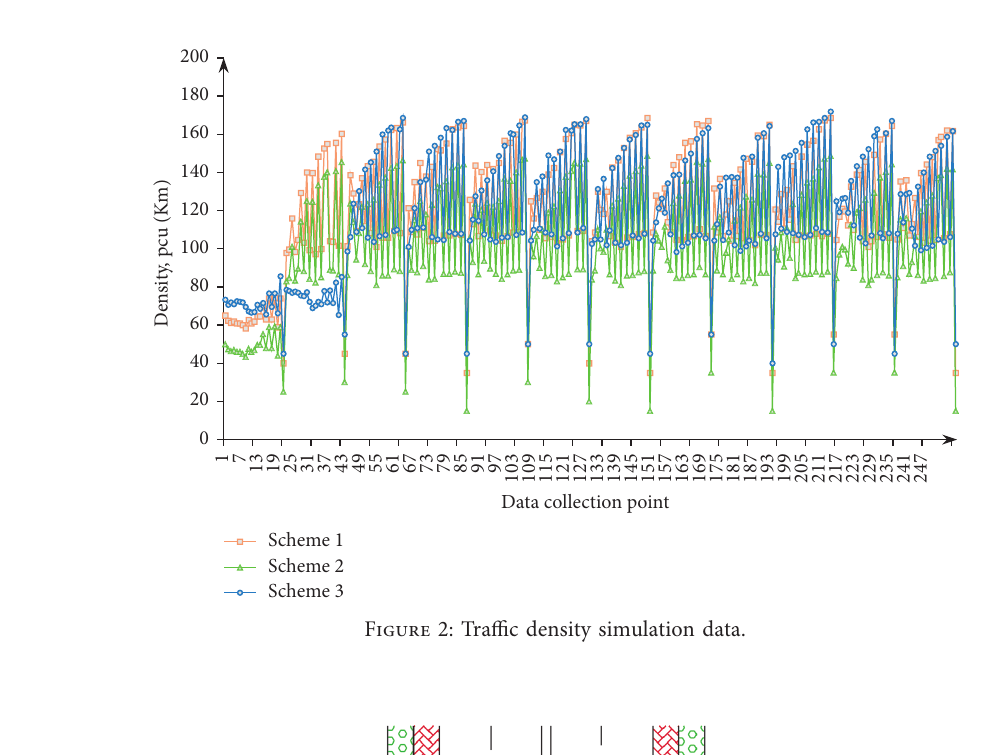
Figure 2: Traffic density simulation data.